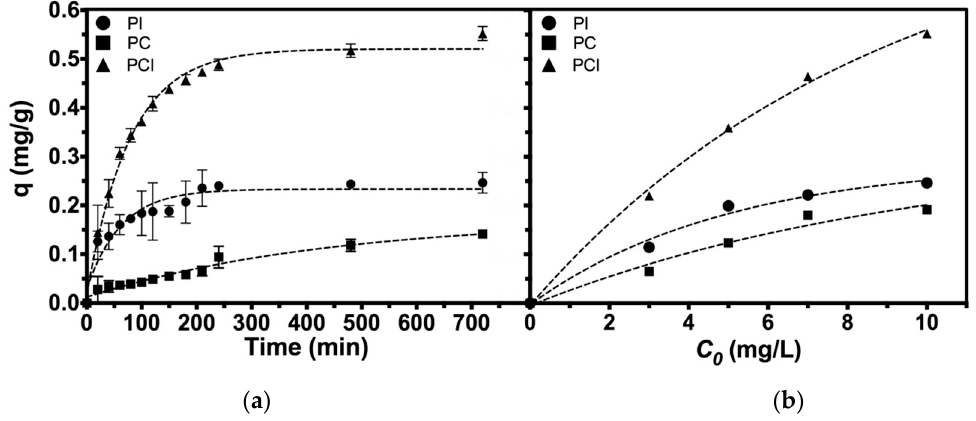
Figure 5. ( a ) Time-dependent adsorption capacity at 25 °C; ( b ) Adsorption capacity, varying initial concentration of lead II(Pb 2+ ). concentration of lead II(Pb 2+